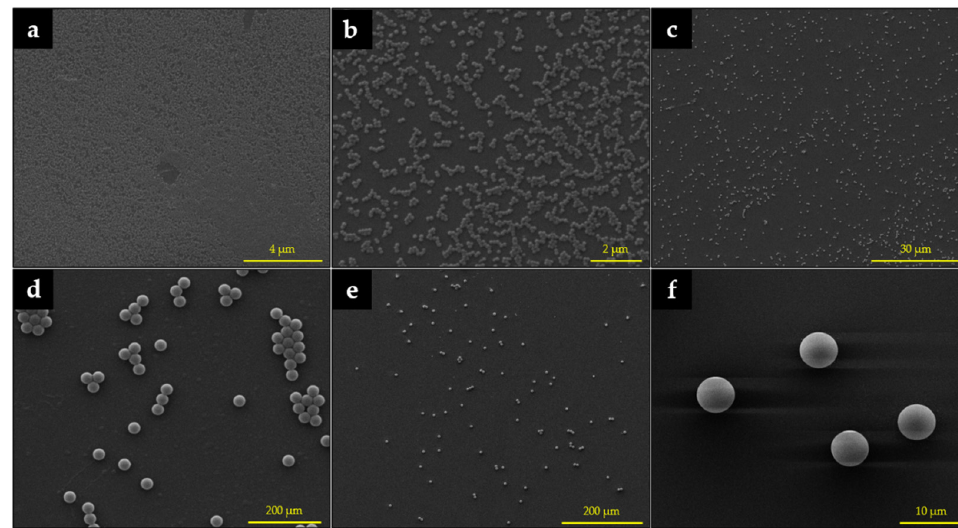
Figure A1. The morphology of polystyrene microplastics of different sizes confirmed using scanning electron microscopy ( a,b ) 0.05 μ m, ( c,d ) 0.5 μ m, ( e,f ) 6.0 μ m.